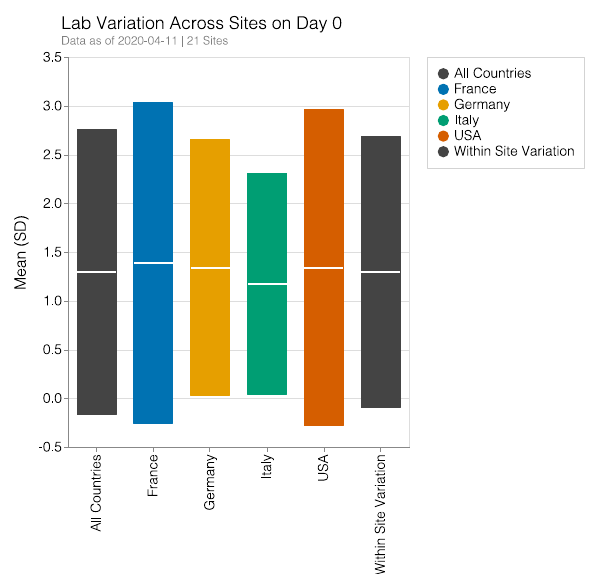
Fig. 5 Laboratory variation across countries and within sites for creatinine test performed within a day of diagnosis. Values for mean value and standard deviation (SD) in creatinine level are shown. Large variations exist within sites and are often larger than the between country variation. The overall SD across countries was 1.47 while the SD within sites was 1.39. Standard deviation for countries was 1.64, 1.31, 1.13, and 1.62 within France, Germany, Italy, and the US,